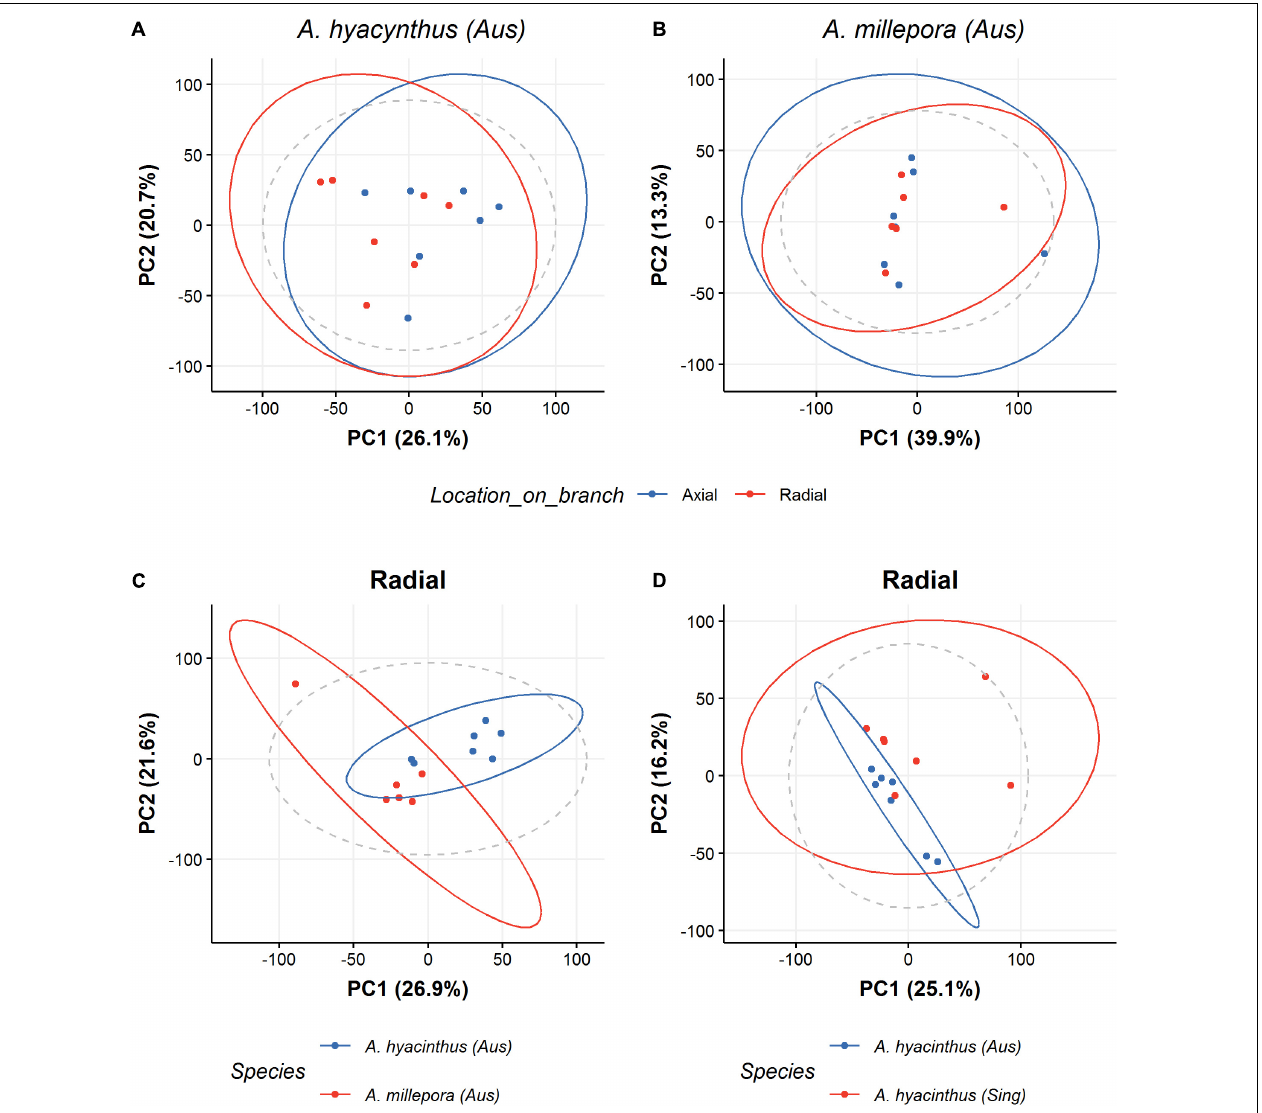
FIGURE 1 | PCA scores plots for LIPID LC-MS results colored according to the locations on the corals from which samples were obtained for A. hyacinthus (A) and A. millepora (B) . Blue dots represent axial polyp sampling and red dots represent radial polyp sampling. (C) A PCA scores plot for the two coral species A. hyacinthus and A. millepora originating from a single sample location (Australia). (D) A PCA scores plot for A. hyacinthus from two locations; Singapore (Sing) and Australia (Aus). Both (C,D) are for Radial samples